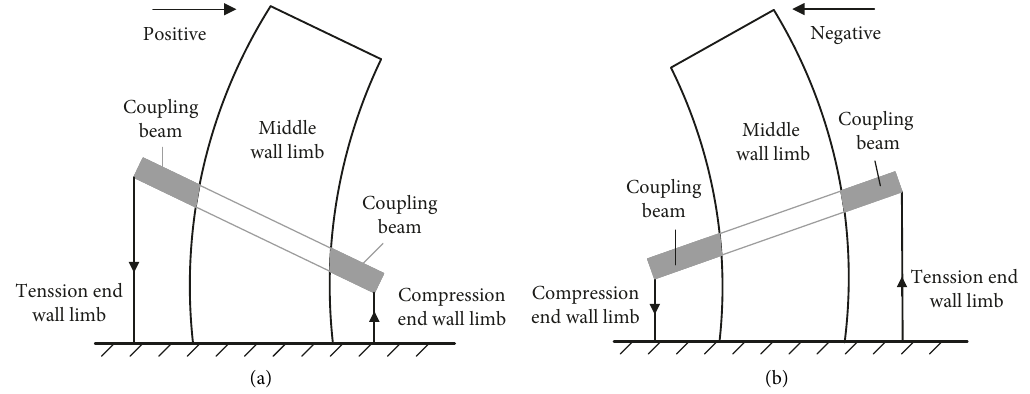
Figure 13: Simplified stress model of diagonal test core wall. (a) Positive. (b) Negative.